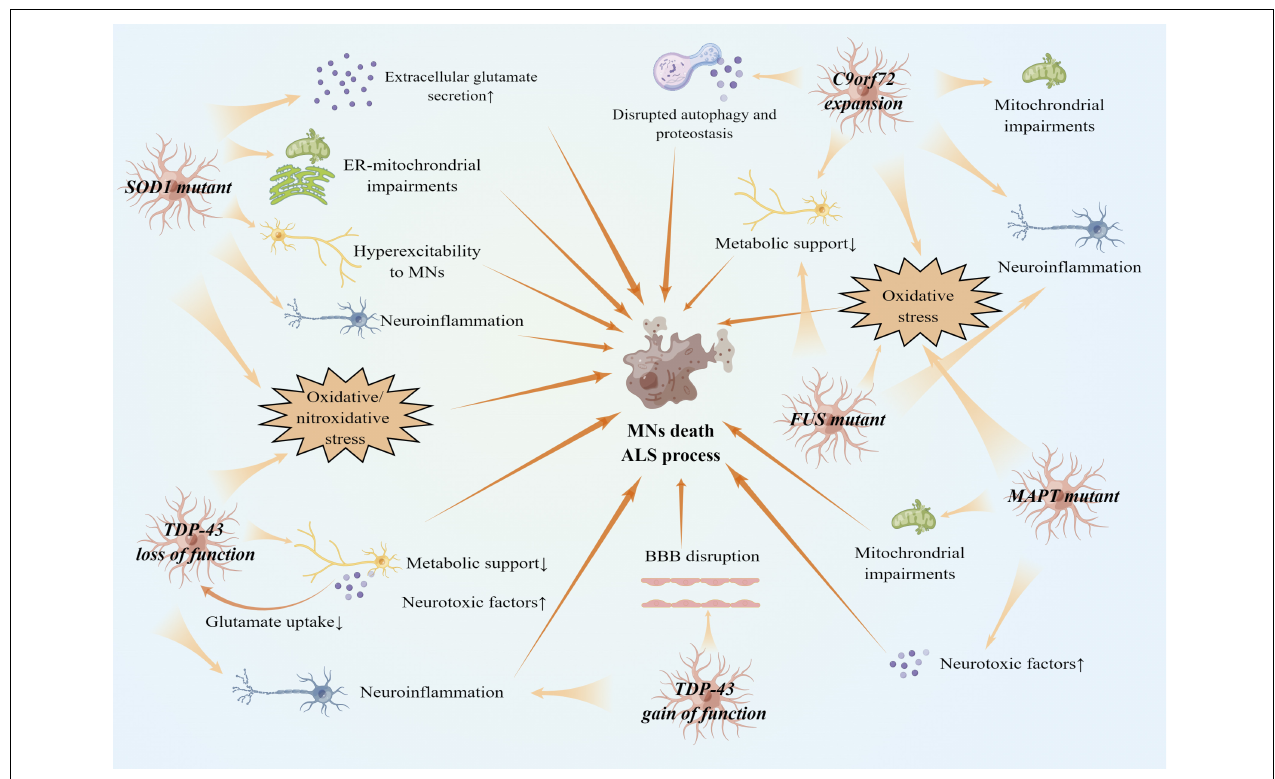
FIGURE 3 | Reactive astrocytes in gene variants of ALS and ALS pathogenesis. There are several faces of astrocytes with gene variants of ALS. SOD1 , TDP-43 , FUS , MAPT variant, and C9orf72 expansion cause oxidative stress in both astrocytes and MNs. SOD1 variants also cause astrocytes to secret extracellular glutamates. Reactive astrocytes with SOD1 variants result in hyperexcitability to MNs. TDP-43 loss of function in astrocytes reduces metabolic support and glutamate uptake, while TDP-43 gain of function in astrocytes damages BBB integrity. Other processes, such as mitochondria impairments, neuroinflammation expansion, and disrupted autophagy and proteostasis, also contribute to MNs